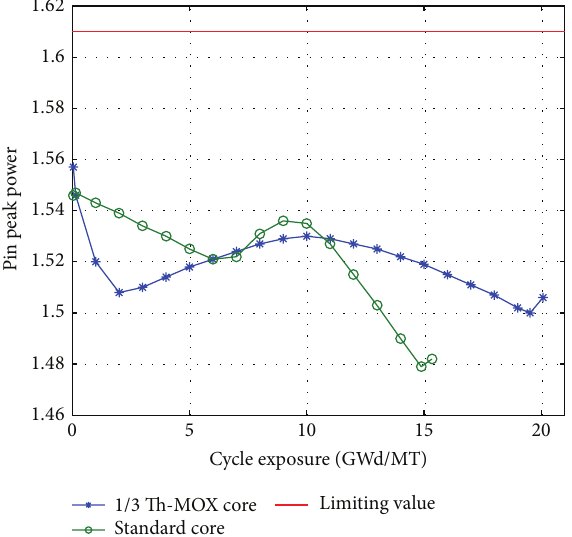
Figure 5: The 𝑘 inf in the Th-MOX and U-G fuel assembly.